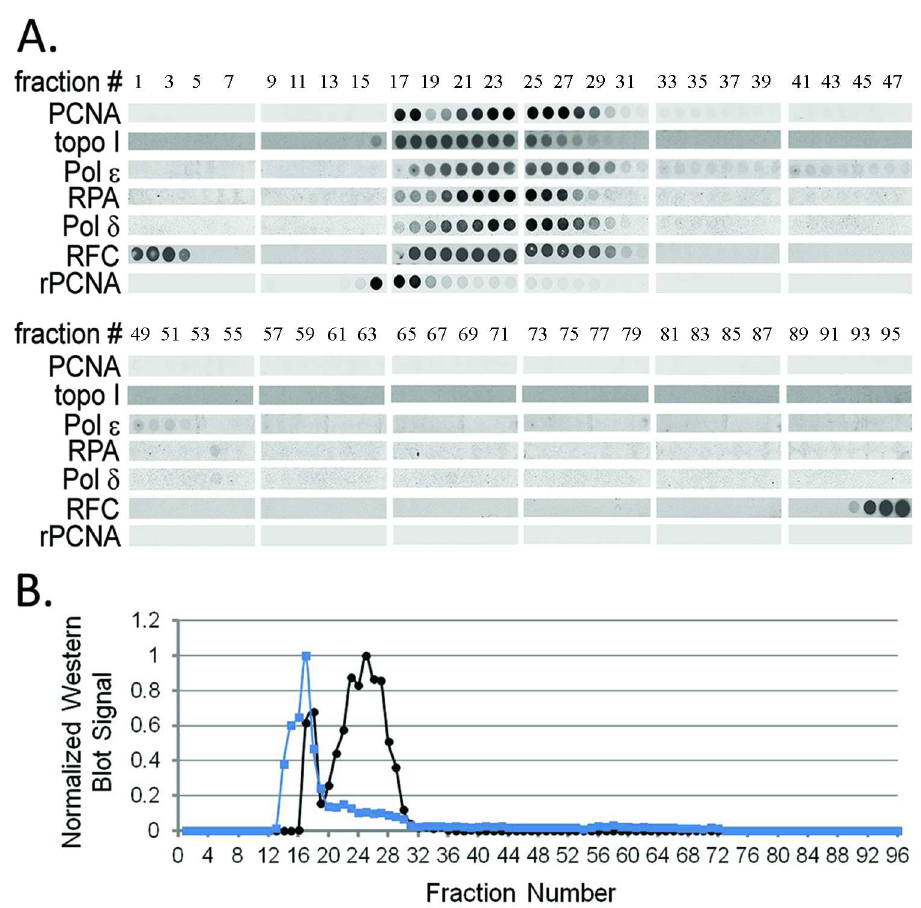
Fig 2. Dot blot analysis of IZE fractions. (A) Dot blot analysisof an IZE separation from the P4 fraction using antibodiesthat recognizePCNA, Topo I, Pol ε subunit2, RPA subunit2, Pol δ catalytic subunit, and RFC subunit 4. Recombinant PCNA (rPCNA) was analyzedfollowingIZE separation of PCNA-FLAG expressedand purifiedprotein.Fraction numbers are labeledat the top of the figure. (B) Dot blot quantification of PCNA. The Western blot signal of each fraction for PCNA from the P4 fraction (black circle) and PCNA-FLAG (blue square) was normalized from 0 to